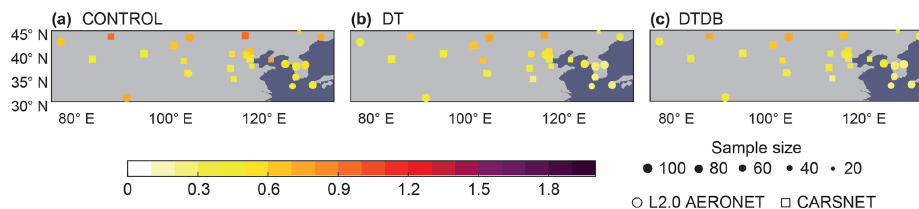
Figure 5. As in for Fig. 4 but for fractional gross error.